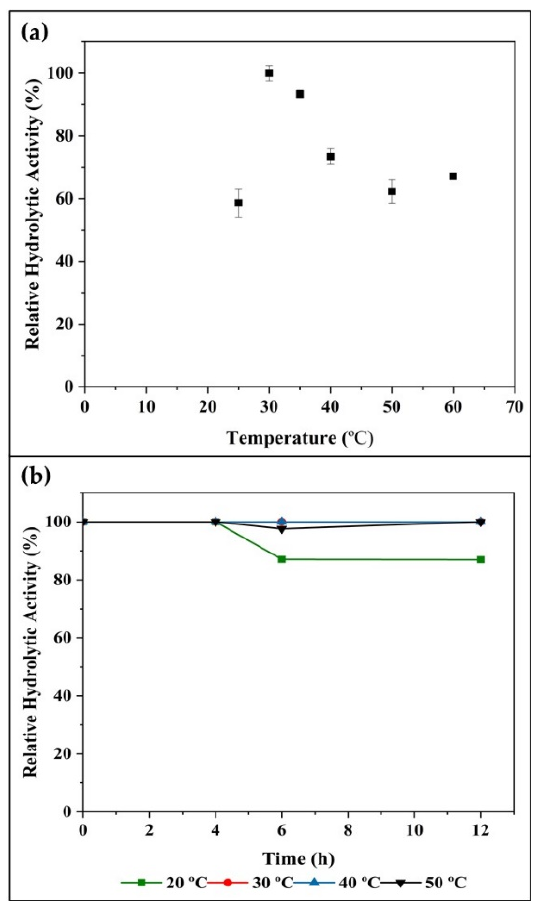
Figure 6. Characterization of A. japonicus lipase immobilized in MKSF support in relation to optimal temperature ( a ) and temperature stability through time (until 12 h of incubation) ( b ). These experiments were performed at pH 8 In the optimal pH, 100% is related to the highest hydrolytic activity achieved. In the pH stability studies, the initial activity obtained at time zero to each pH was considered 100% (different values for each temperature values). The error bars represent the standard deviation of triplicates.